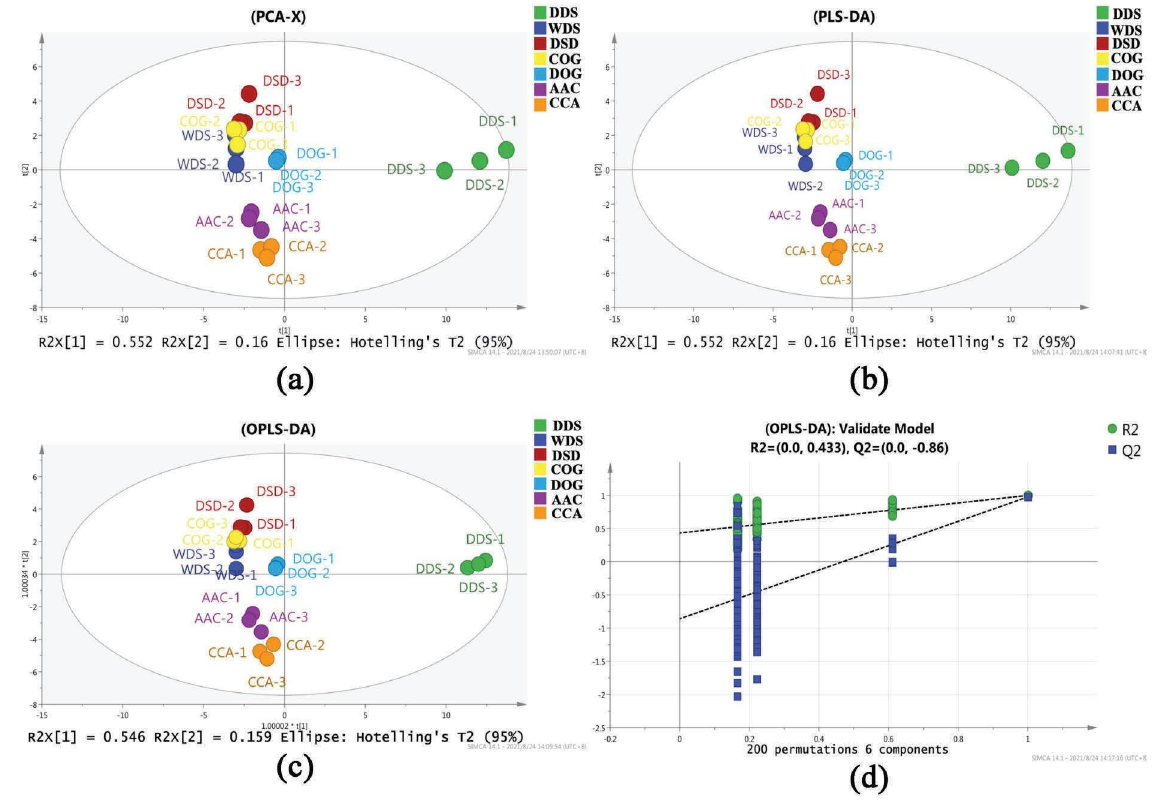
Figure 5: (a) PCA score chart. (b) PLS-DA score chart. (c) OPLS-DA score chart. (d) Permutation test results of volatile favor compounds in Ejiao at diferent processing